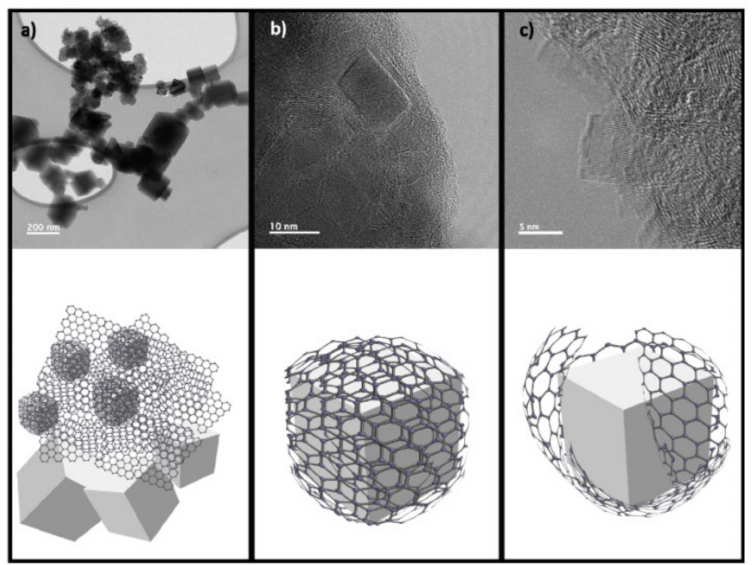
Figure 13. TEM micrographs and proposed dissolution mechanism. MgO nanoparticles surrounded by graphite ( a ), ( b ) MgO nanoparticles covered with several graphene layers and ( c ) graphite exfolia- tion by mechanical